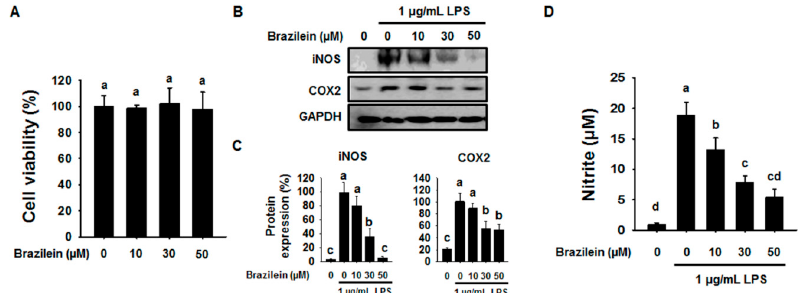
Figure 1. Brazilein attenuated inducible nitric oxide synthase (iNOS) and cyclooxygenase-2 (COX2) protein levels and nitrite production in lipopolysaccharide (LPS)-induced Raw264.7. ( A ) Raw264.7 (5 × 10 3 cells/well) were incubated with 10, 30 or 50 μ M brazilein for 24 h. Cytotoxic evaluation of brazilein on Raw264.7. ( n = 5); ( B ) Raw264.7 (5 × 10 5 cells/well) were pre-incubated with 10, 30 or 50 μ M brazilein for 1 h and then treated with 1 μ g/mL LPS for an additional 24 h. DMSO was used as a vehicle. The protein levels of iNOS and COX2 were determined by western blotting; ( C ) The quantification histogram of iNOS and COX2 protein expression normalized by GAPDH. ( n = 3); ( D ) Culture media was subsequently isolated and nitrite concentrations determined. The data are expressed as mean ± standard deviations (SD), ( n = 3). Values with different letters are significantly different, p < 0.05.